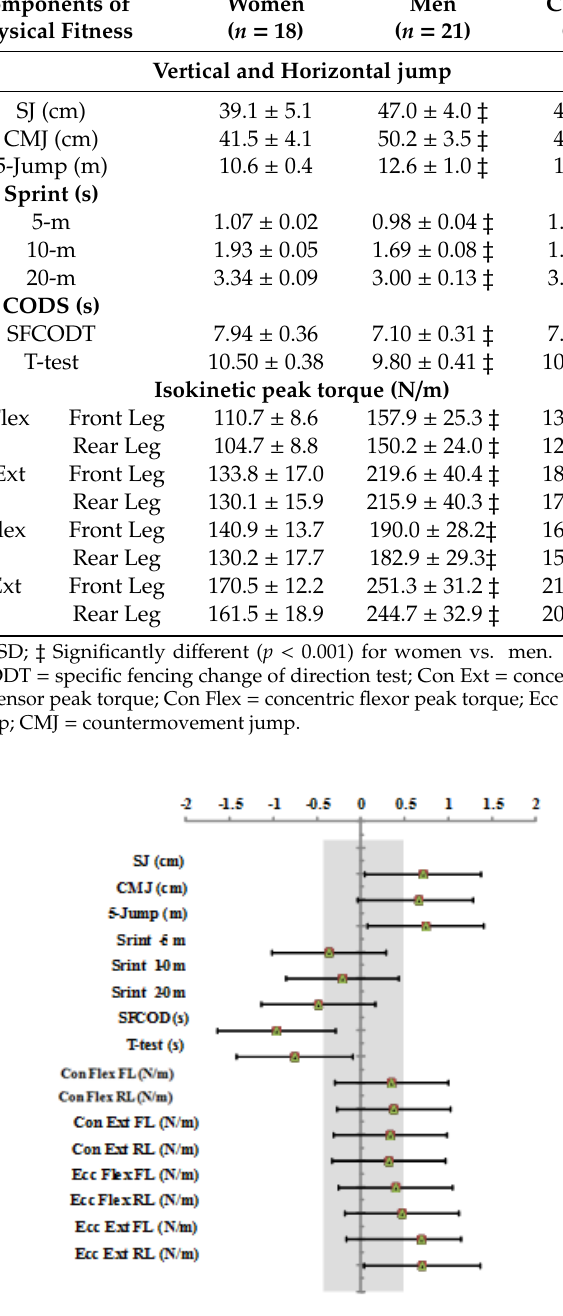
Figure 2. E ff ect size, with 95% confidence interval, between high- vs. low-ranked fencer Figure 2. Effect size, with 95% confidence interval, between high- vs. low-ranked fencer athletes.